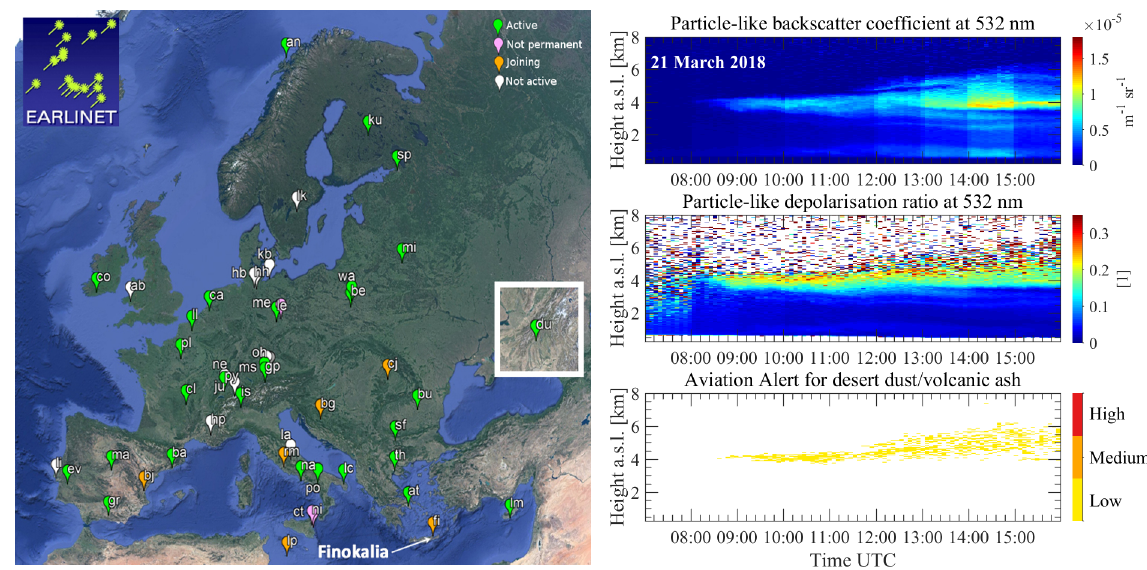
Figure 13. Left panel: map of the EARLINET network (from https://www.earlinet.org, last access: 5 November 2021). Right panels: illus- tration of desert dust/volcanic-ash alerts (station Finokalia) during a desert dust storm on 21 March 2018 (particle backscatter coefficient at 532nm, particle depolarisation ratio at 532nm and alert for